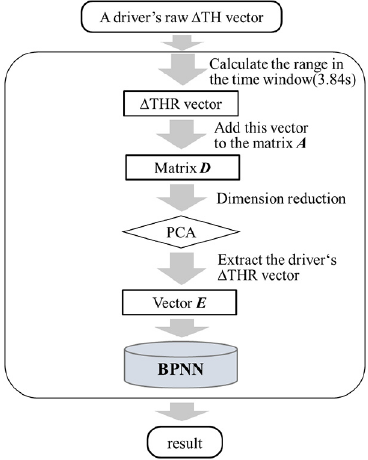
Figure 7 Typical BPNN structure with one hidden layer